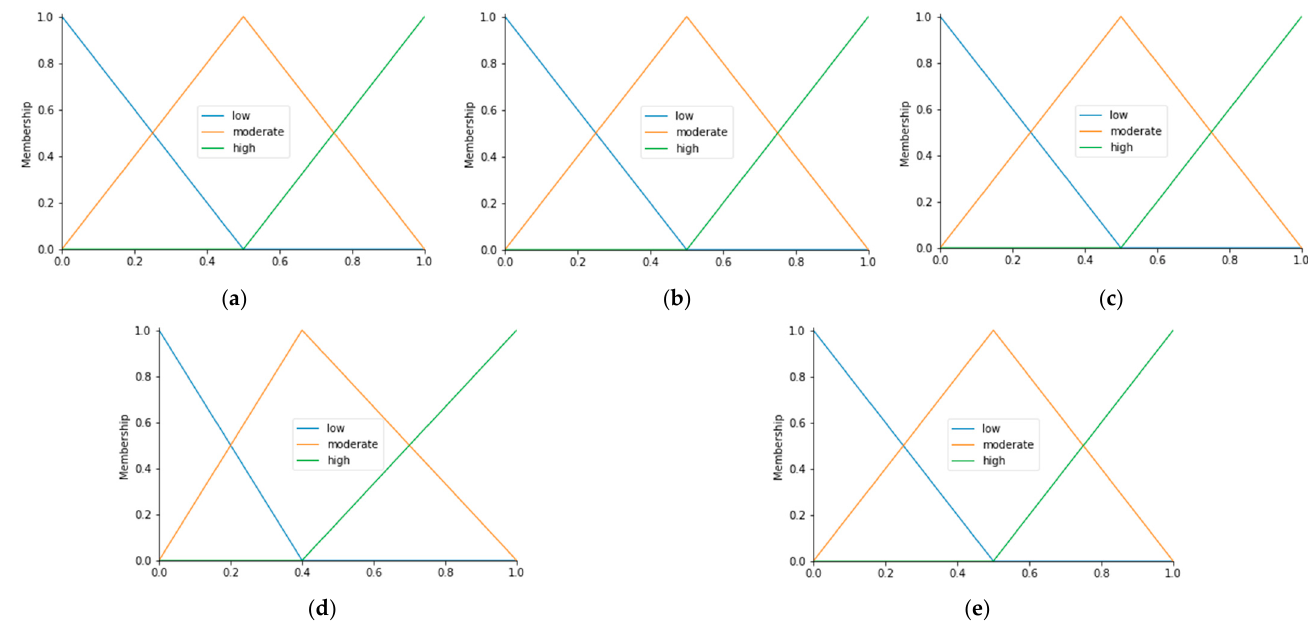
Figure 6. Membership functions of input variables: ( a ) plan irregularity; ( b ) vertical irregularity; ( c ) construction quality; ( d ) construction year; and ( e ) structural system.